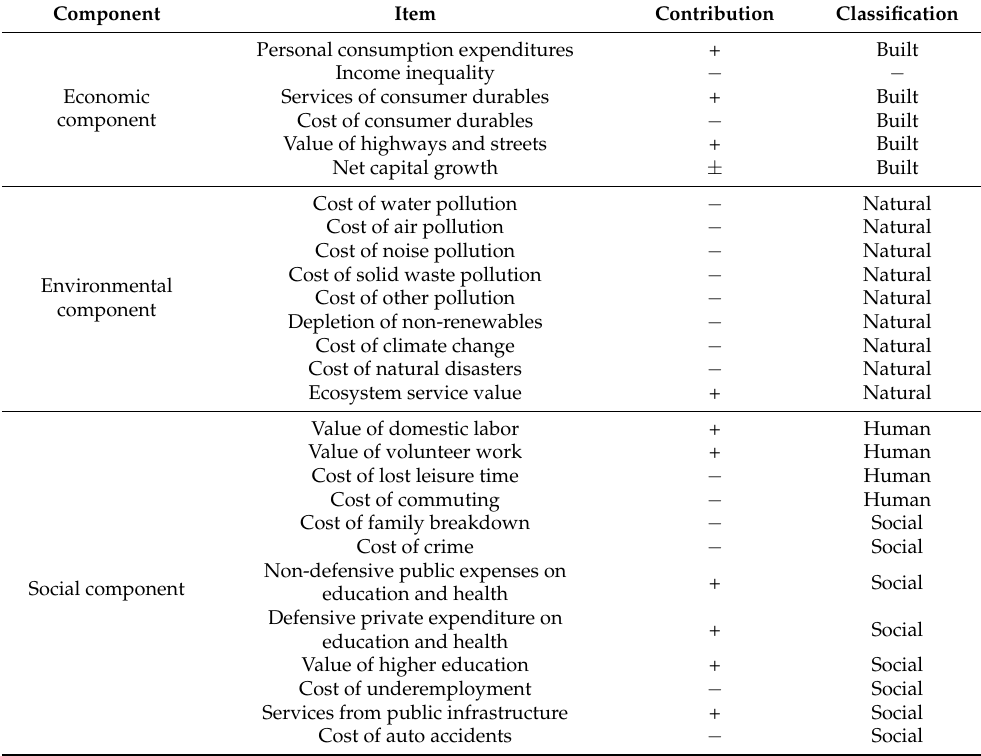
Table 1. The indicators of the revised